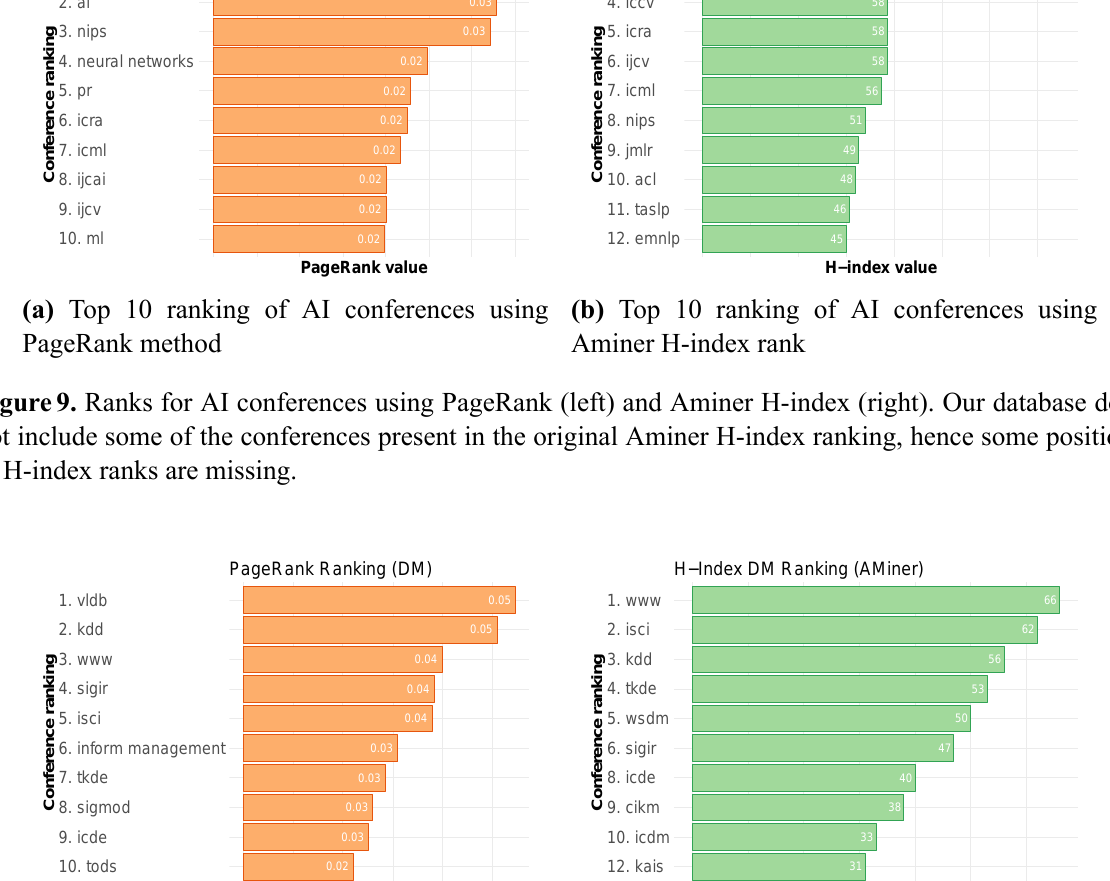
Figure 10. Ranks for DM conferences using PageRank (left) and Aminer H-index (right). Our database does not include some of the conferences present in the original Aminer H-index ranking, hence some positions in H-index ranks are